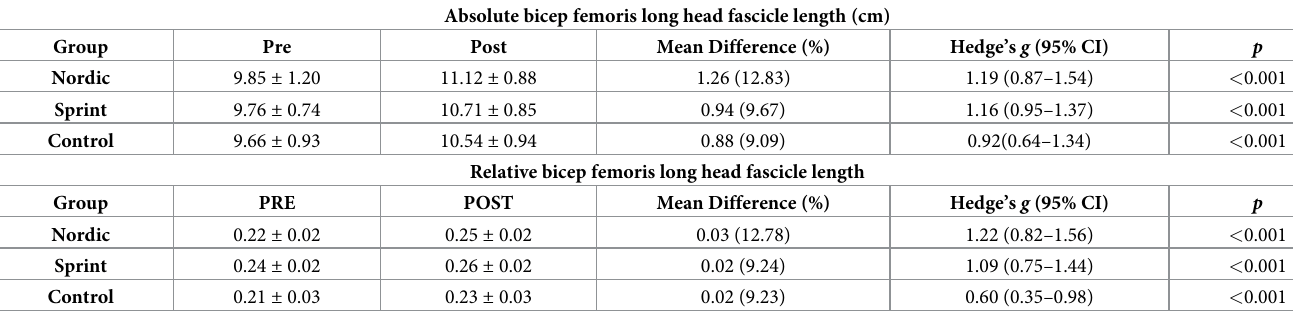
Table 5. Pairwise comparisons of Bicep femoris fascicle length for all training groups.